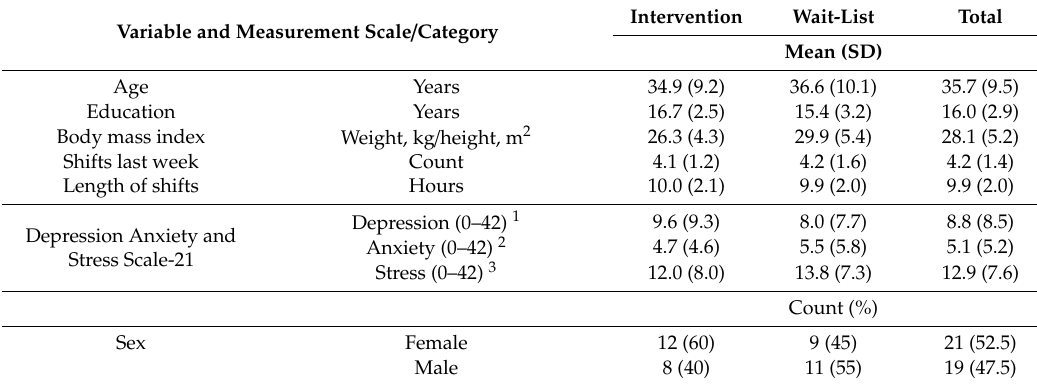
Table 1. Sociodemographic and health descriptors of shift-worker Move, Eat, and Sleep participants ( n =